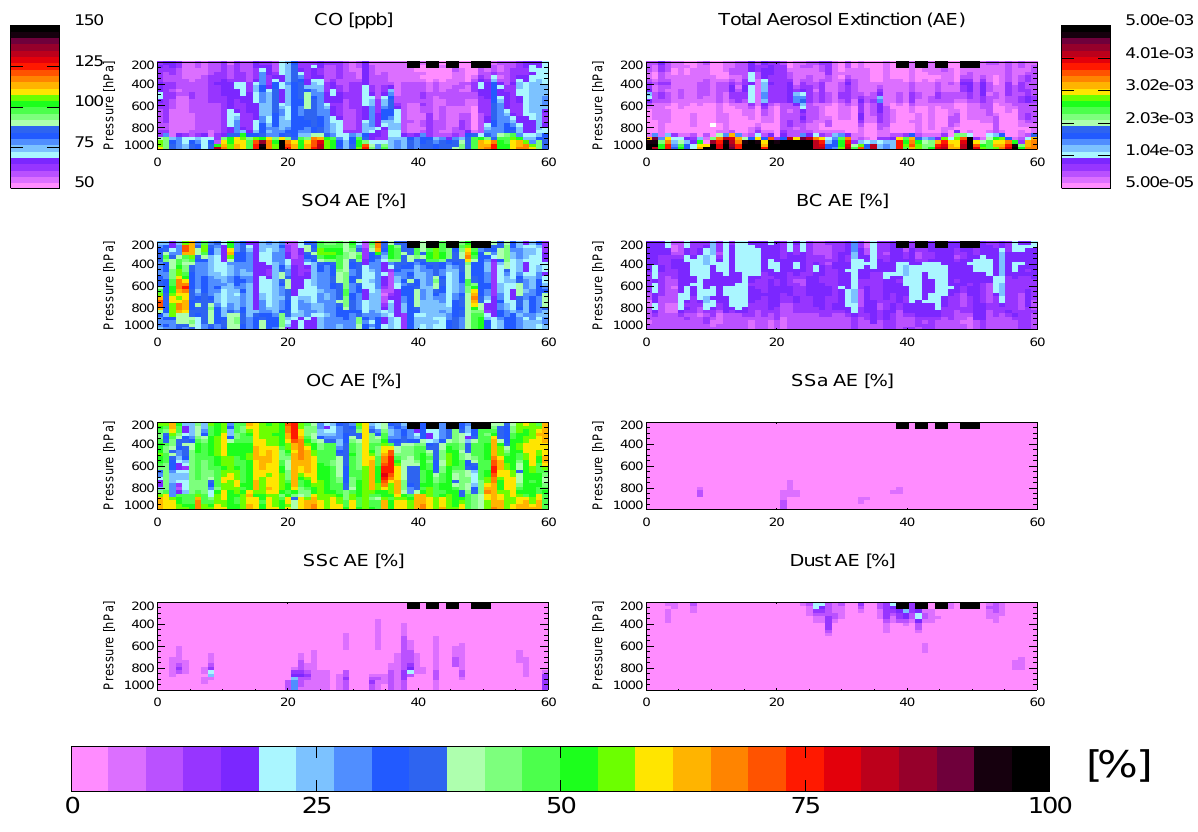
Fig. 5. Model vertical profiles of CO [ppb], aerosol extinction and its percentage source contributions from sulphate, black carbon (BC), organic carbon (OC), sea salt in accumulation (SSa) and coarse (SSc) modes, and desert dust for June–July 2008 (described as the days from 1 June 2008). The black squares at the top of each panel denote the days on which there were ACES/OP3 aircraft